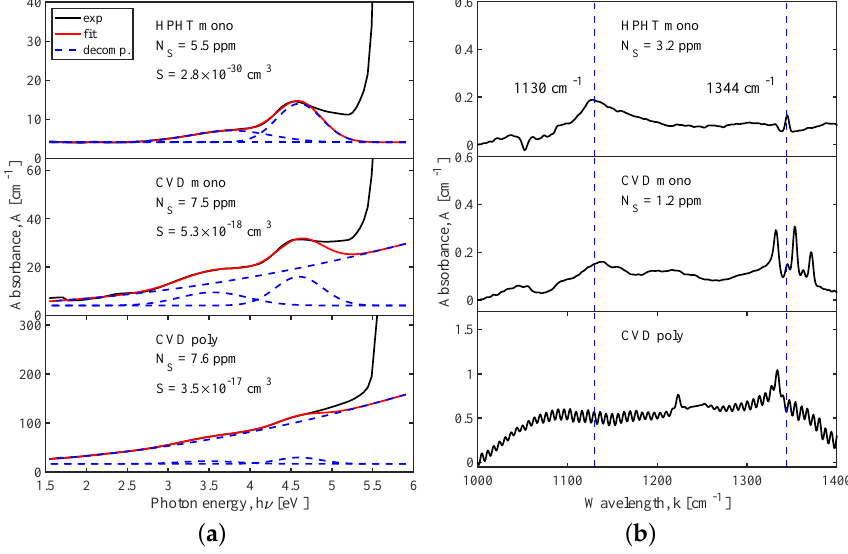
Figure 2. Optical absorption of diamond substrates of different origins in ( a ) UV-visible and ( b ) IR ranges. In UV-visible spectra, the solid red and dashed blue lines indicate spectrum decomposition and the corresponding individual channels of optical losses, including nitrogen absorption and Rayleigh scattering. In IR spectra, the blue vertical lines mark the bands characterizing substitu- tional nitrogen.